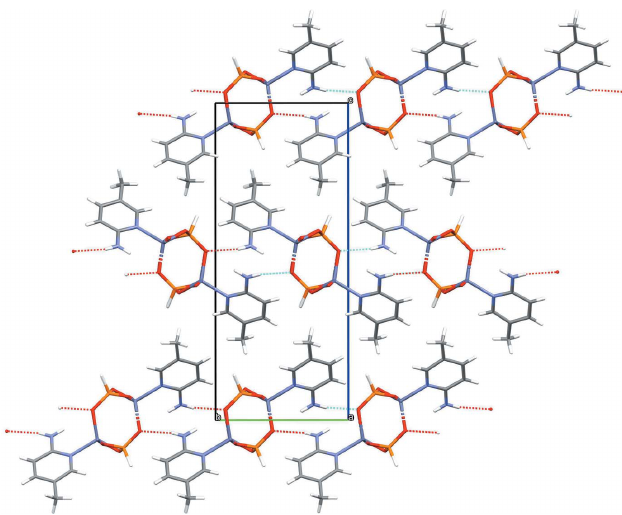
Figure 9 The unit-cell packing in (II) viewed down [101]. Hydrogen bonds are shown as dashed lines.